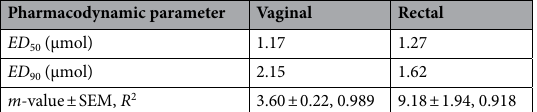
Pharmacodynamic parameter